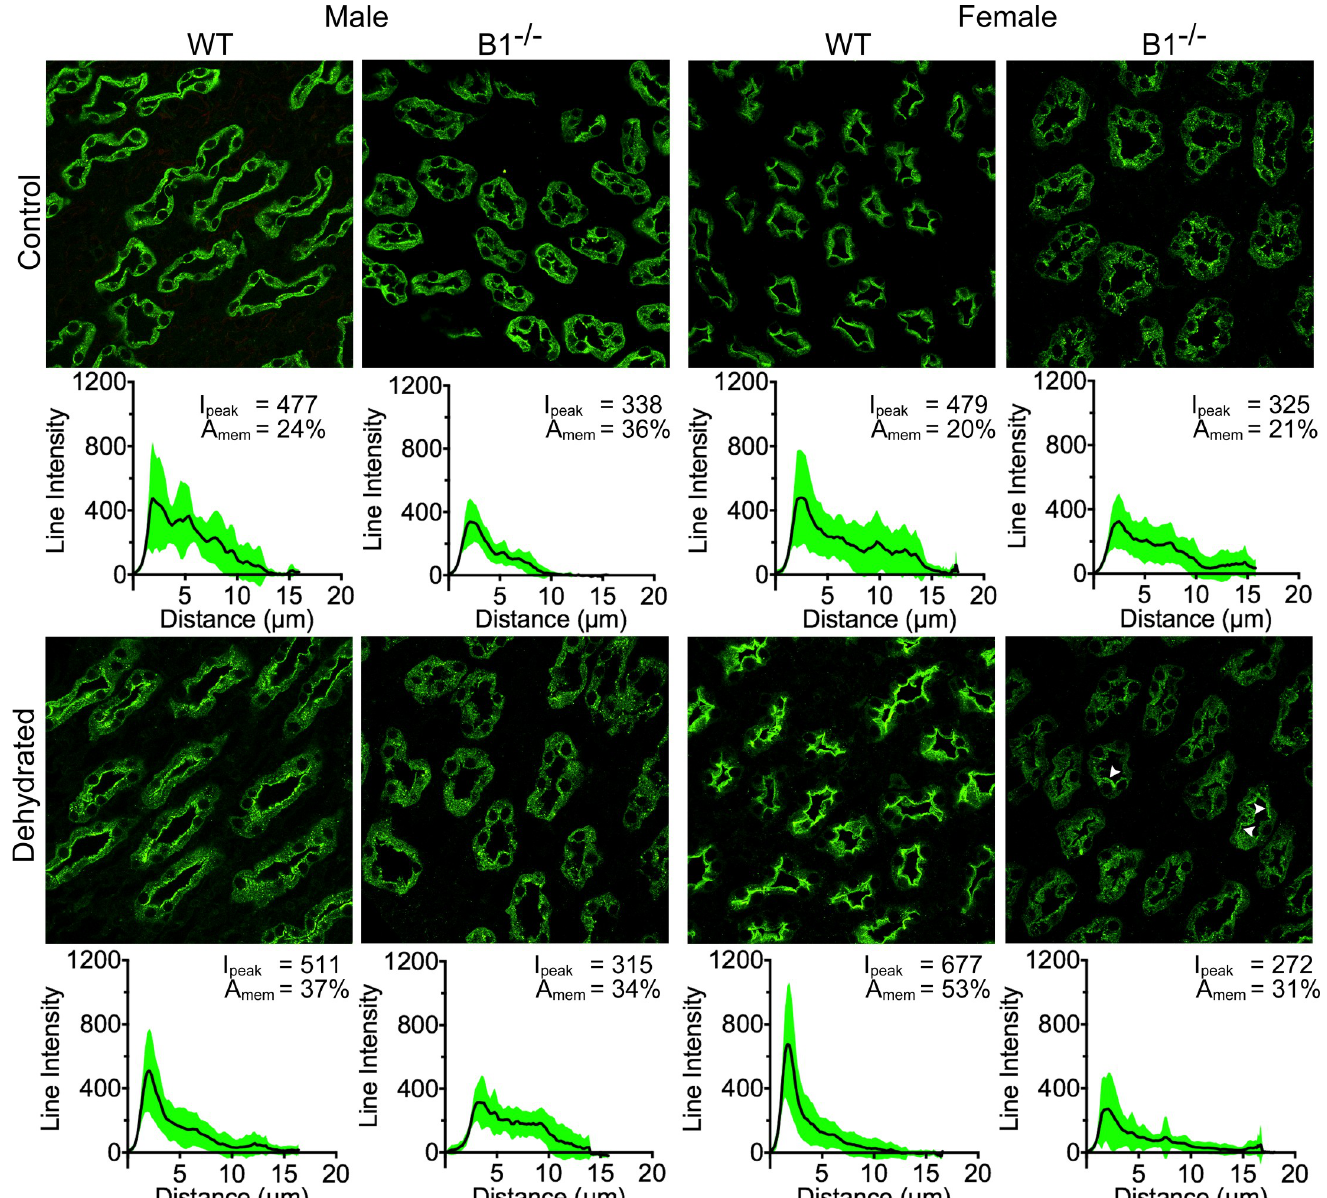
Fig 7. Female WT mice regulate AQP2 more than males in the tip of the inner medulla. Male WT animals showed little increase of peak intensity after dehydration (only 7%), even though the presence of AQP2 in the membrane region increased by 54% (1 st column). On the other hand male B1 -/- mice did not exhibit any regulation of AQP2 upon dehydration (2 nd column). In contrast, female WT animals had a considerable amount of regulation of AQP2 in this region with a 41% increase in peak intensity and a 160% increase in AQP2 in the membrane region (3 rd column). Female B1 -/- animals also showed an increase in AQP2 in the membrane vicinity, but peak intensity was reduced (4 th column). Similar to the base of IM, there were many cells with a clear membrane expression of AQP2 (white arrowheads) although the overall peak intensity was